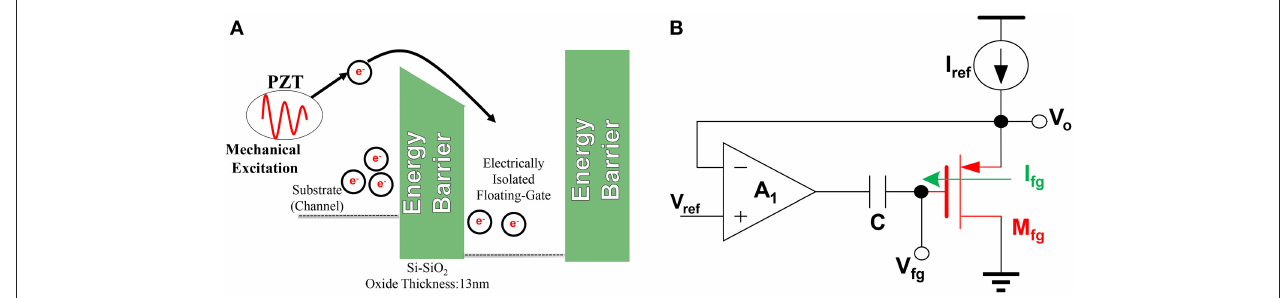
FIGURE 1 | Circuit detail and illustration of Impact-Ionized Hot-Electron Injection (IIHEI) in Piezoelectric-Floating-Gate (PFG) sensors. (A) Illustration showing that mechanical excitation of a piezoelectric can propel electrons beyond an energy barrier. Electrons on their own will remain trapped between barriers. (B) The feedback amplifier, A 1 , enables linearized injection onto floating-gate, M fg